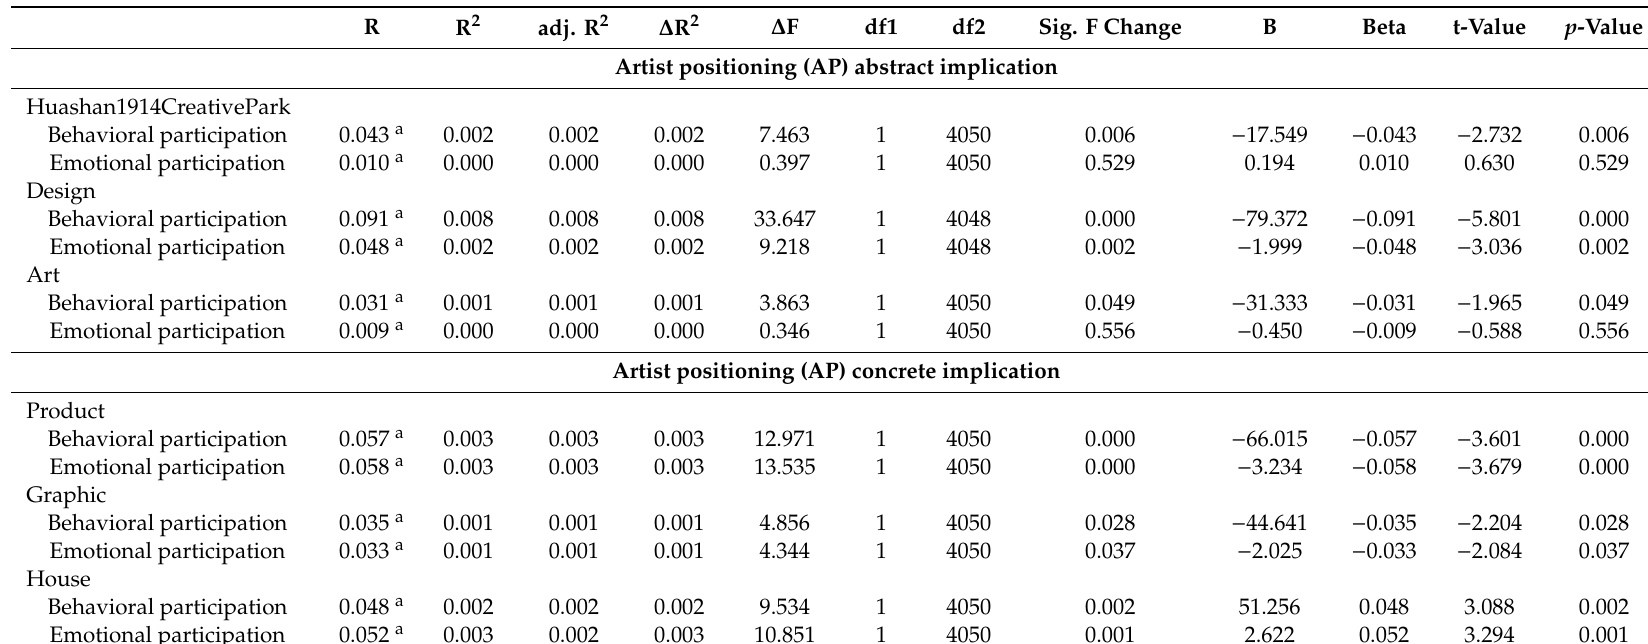
Table A5. Linear regression coe ffi cient of determination and beta (artist positioning